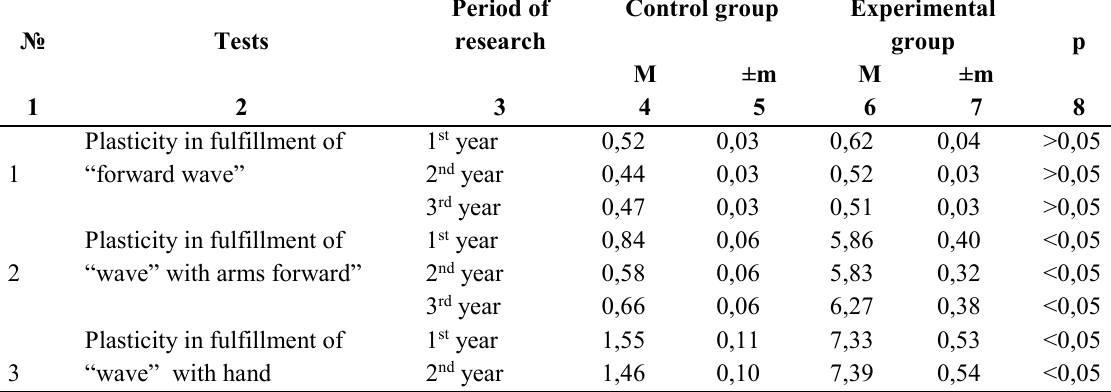
Table 1. Increment of indicators (in %) of different plasticity kinds № Tests